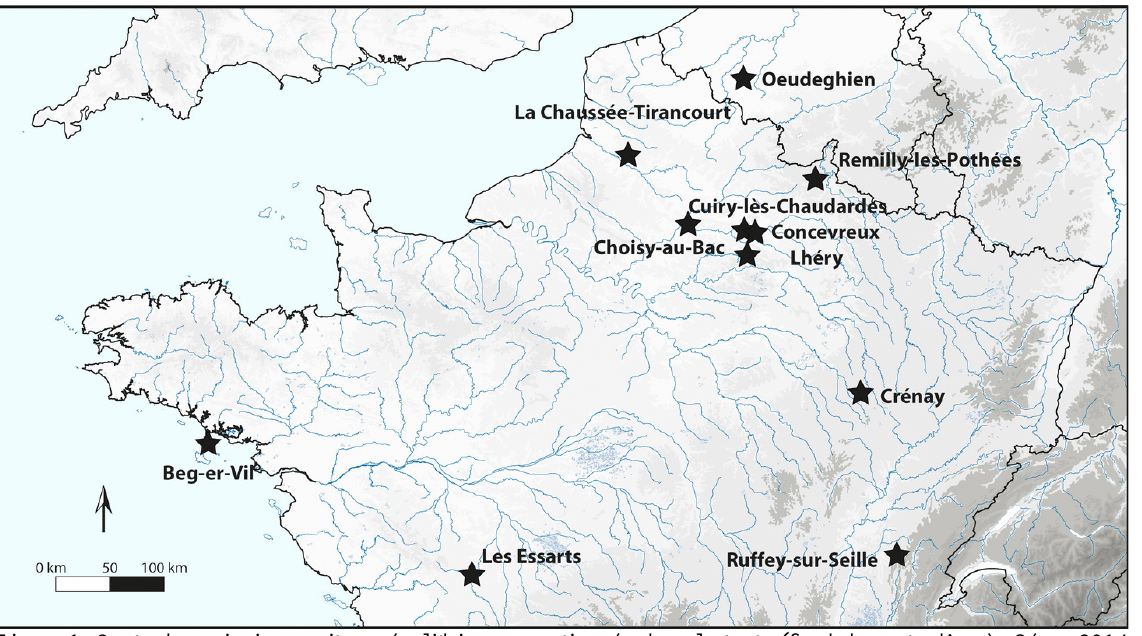
Figure 1. Carte des principaux sites mésolithiques mentionnés dans le texte (fond de carte d’après Séara 2014 modifié). Figure 1. Map of the main Mesolithic sites mentioned in the text (background map after Séara 2014,